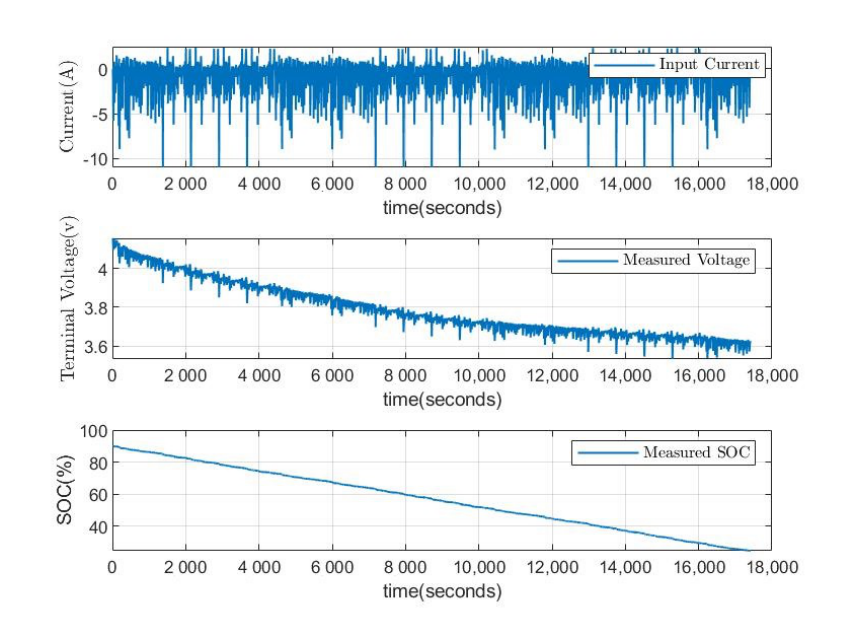
Figure 6. Voltage, current, and SoC for a cell using a mixed drive